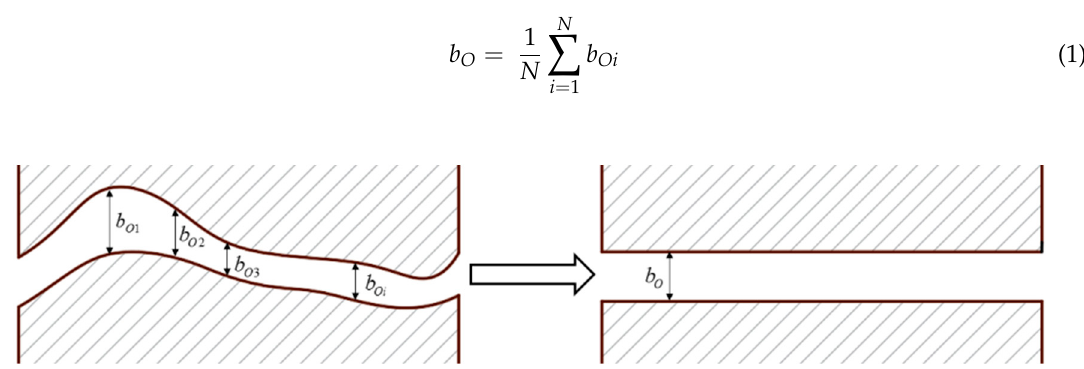
Figure 1. Schematic diagram of rough fracture and equivalent plate fracture.